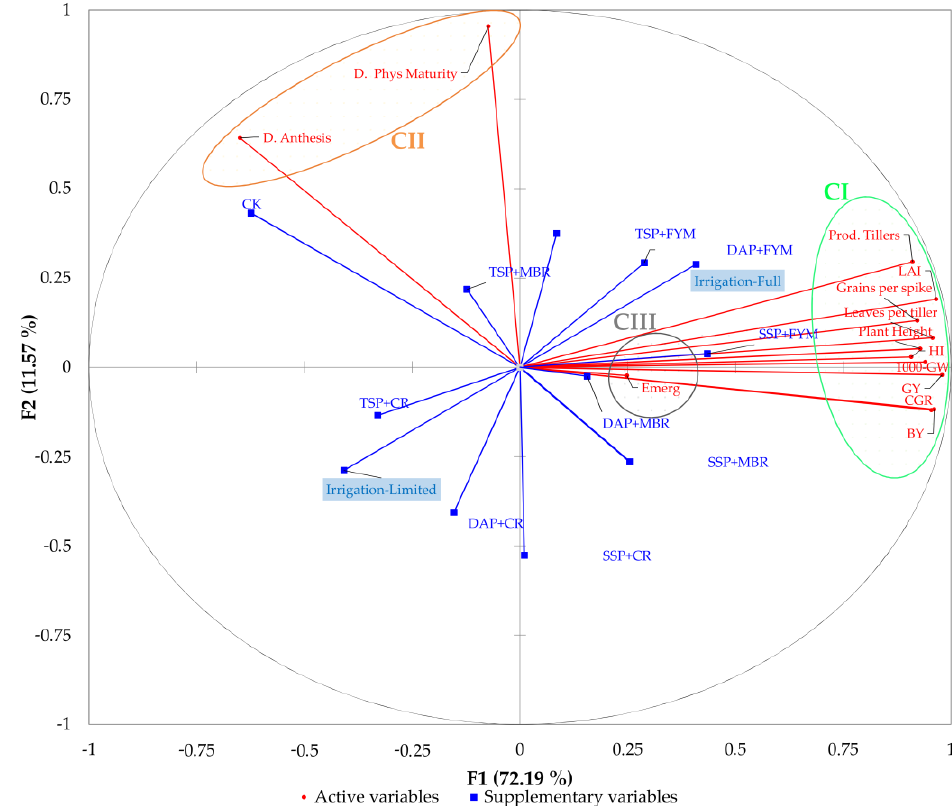
Figure 3. Principal component analysis (PCA) plot of various growth, physiological, and yield traits in the 10 investigated treatments applied on wheat grown under different irrigation regimes. F1 and F2 are the first two components (PCs) with eigenvalues ≥1. FYM = farmyard manure; MBR = mung bean residue; CR = canola residue; TSP = triple super phosphate; SSP = single super phosphate; and DAP = di-ammonium phosphate. CGR = Crop Growth Rate; LAI = Leaf Area Index; 1000-GW = Thousand-Grain Weight; BY = Biological yield; GY = Grain Yield; HI = Harvest Index; Prod. Tillers = Productive Tillers; Emerg = Emergence − 2 ; D. Anthesis = Days to Anthesis; D. Phys Maturity = Days to Maturity.